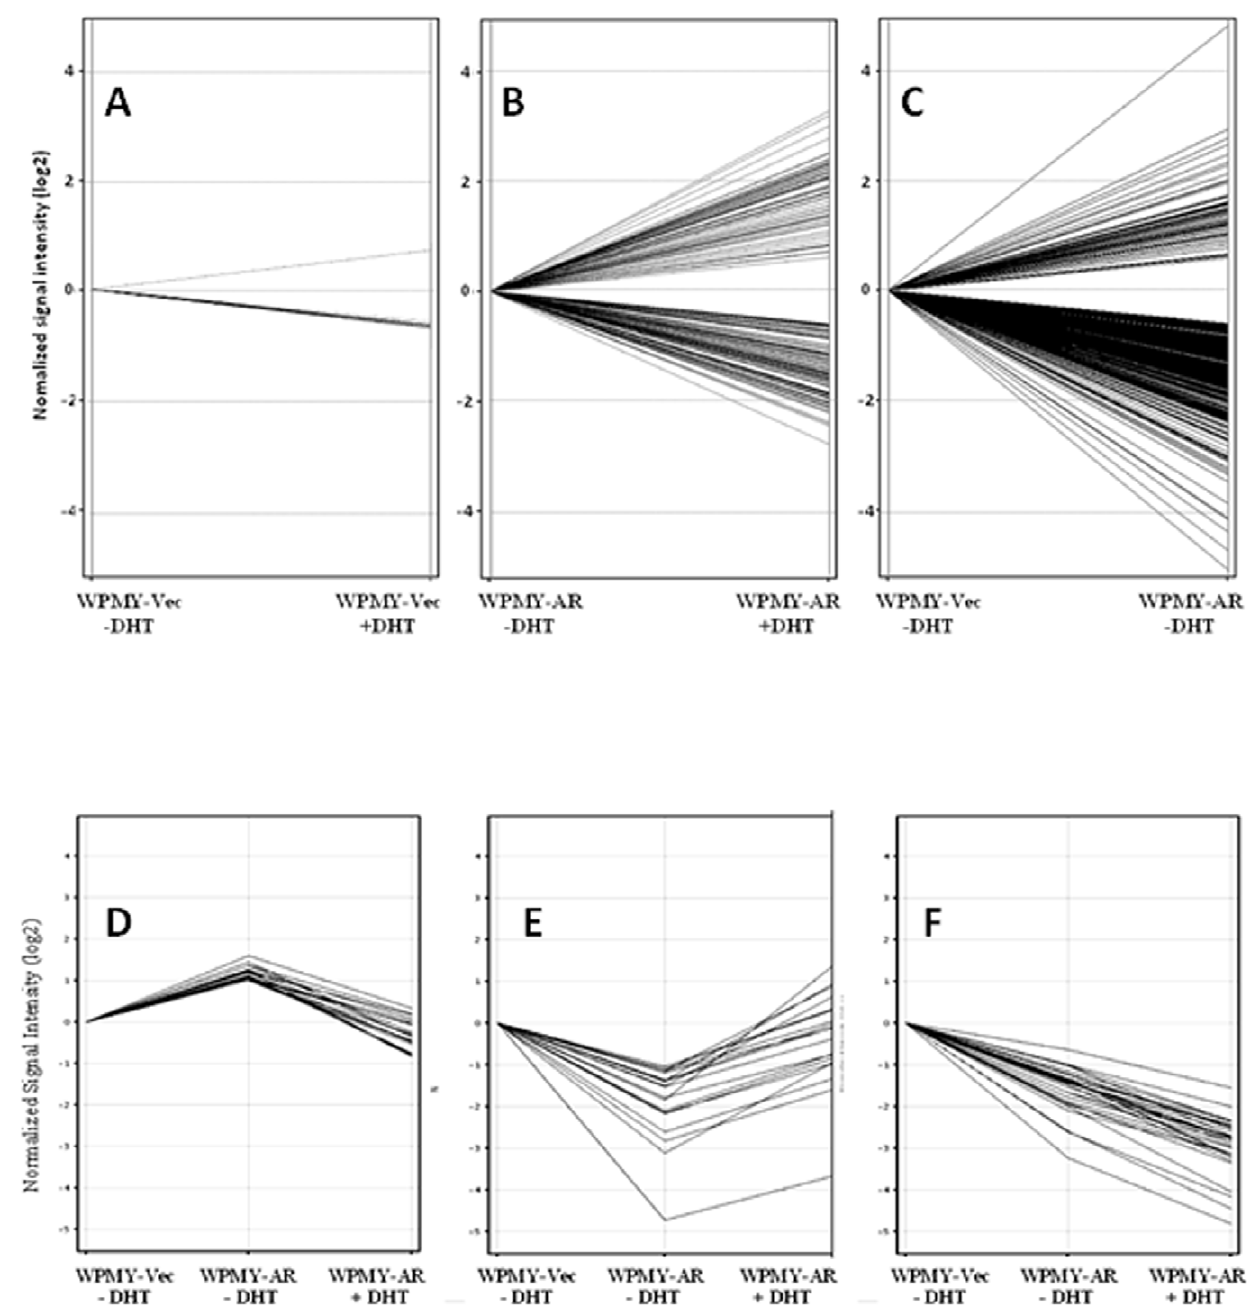
Figure 2. Gene expression changes associated with expression of AR in the absence or presence of DHT in WPMY-1 prostate stromal cells. (A) GeneSpring-generated line plot of significant (P , 0.05) gene expression differences greater than 1.5-fold in WPMY-Vec cells treated for 72 hrs with 10 nM DHT. (B) GeneSpring-generated line plot of significant (P , 0.05) gene expression differences greater than 1.5-fold in WPMY-AR cells treated for 72 hrs with 10 nM DHT. (C) GeneSpring-generated line plot of significant (P , 0.05) gene expression differences greater than 1.5-fold between WPMY-Vec and WPMY-AR cells grown without DHT. (D) GeneSpring-generated line plot showing effect of DHT treatment on genes that were differentially upregulated by 2-fold or greater by AR expression alone (no DHT). (E) GeneSpring generated line plot showing effect of DHT treatment on genes that were differentially down-regulated by 2-fold or greater by AR expression alone (no DHT) and were subsequently up- regulated by 2-fold in the presence of DHT. (F) GeneSpring generated line plot showing effect of DHT treatment on genes that were differentially down-regulated by 2-fold or greater by AR expression alone (no DHT) and were subsequently further down-regulated by 2-fold or greater in the presence of DHT. doi:10.1371/journal.pone.0016027.g002 for expression of AR and for expression of the same 10 genes that than in control-transfected PS30 cells. As is shown in Figure 3B, were selectively analyzed in WPMY-AR cells. The outcomes expression of 6 of the other 10 genes were changed in the same showed that AR was expressed 923-fold more in AR-transfected manner as for the WPMY-AR cells treated with DHT, whereas 4